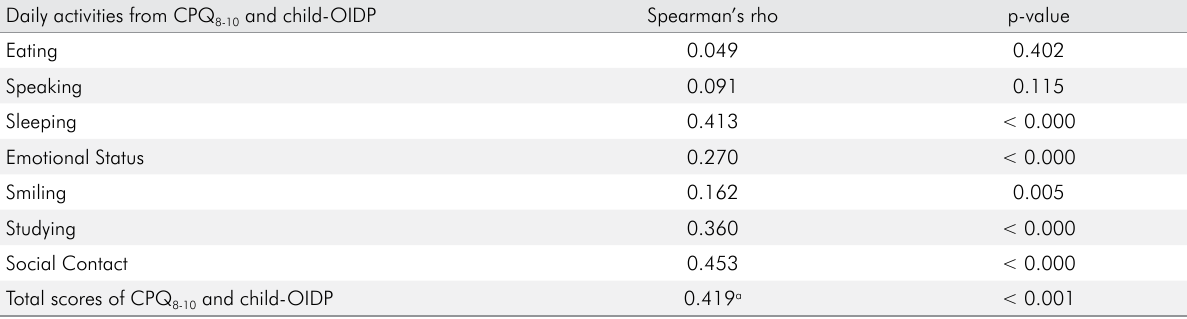
and child-OIDP. 8-10